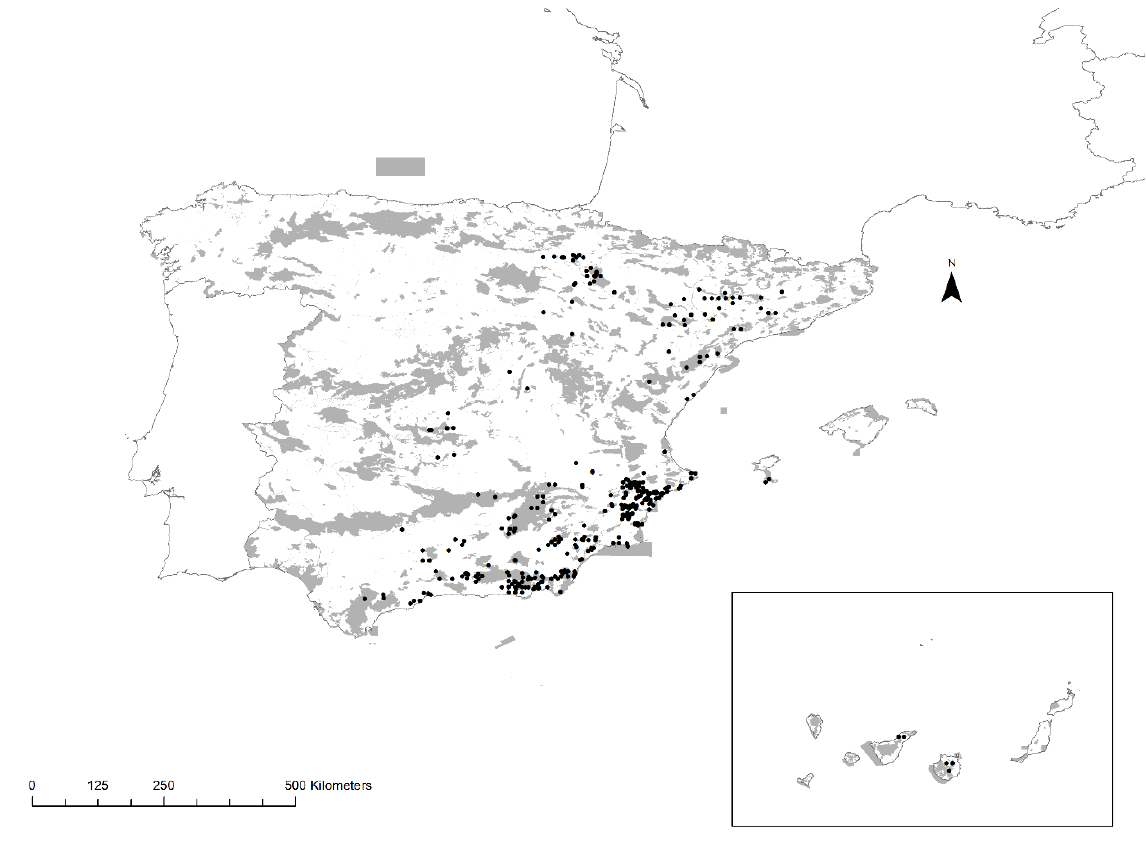
Figure 1. Distribution of the occurrence data of target threatened and endemic CWR of Spain. Grey areas correspond to Sites of Community Interest – Natura